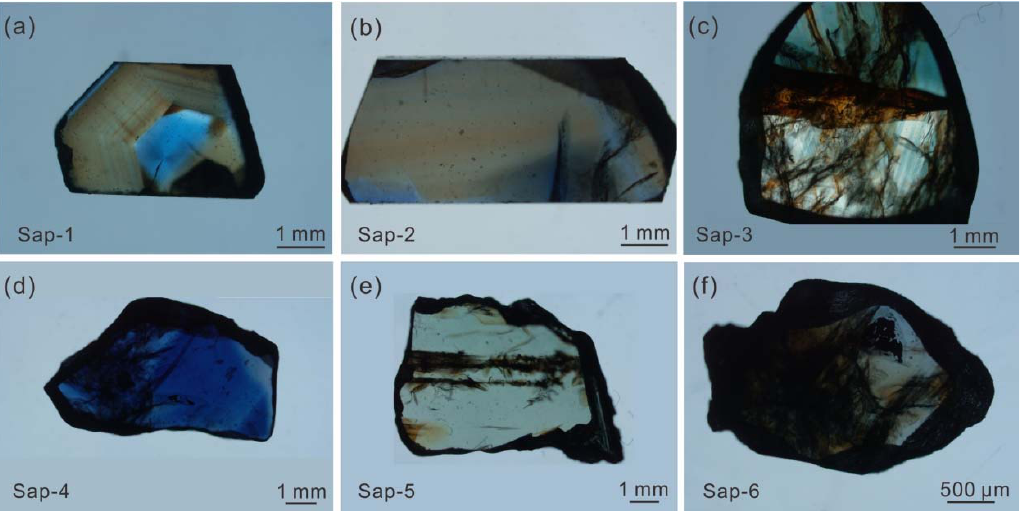
Figure 3. The cut and polished sapphire samples from the Penglai alluvial deposit: ( a ) Sap ‐ 1; ( b ) Sap ‐ 2; ( c ) Sap ‐ 3; ( d ) Sap ‐ 4; ( e ) Sap ‐ 5; ( f ) Sap ‐ 6.